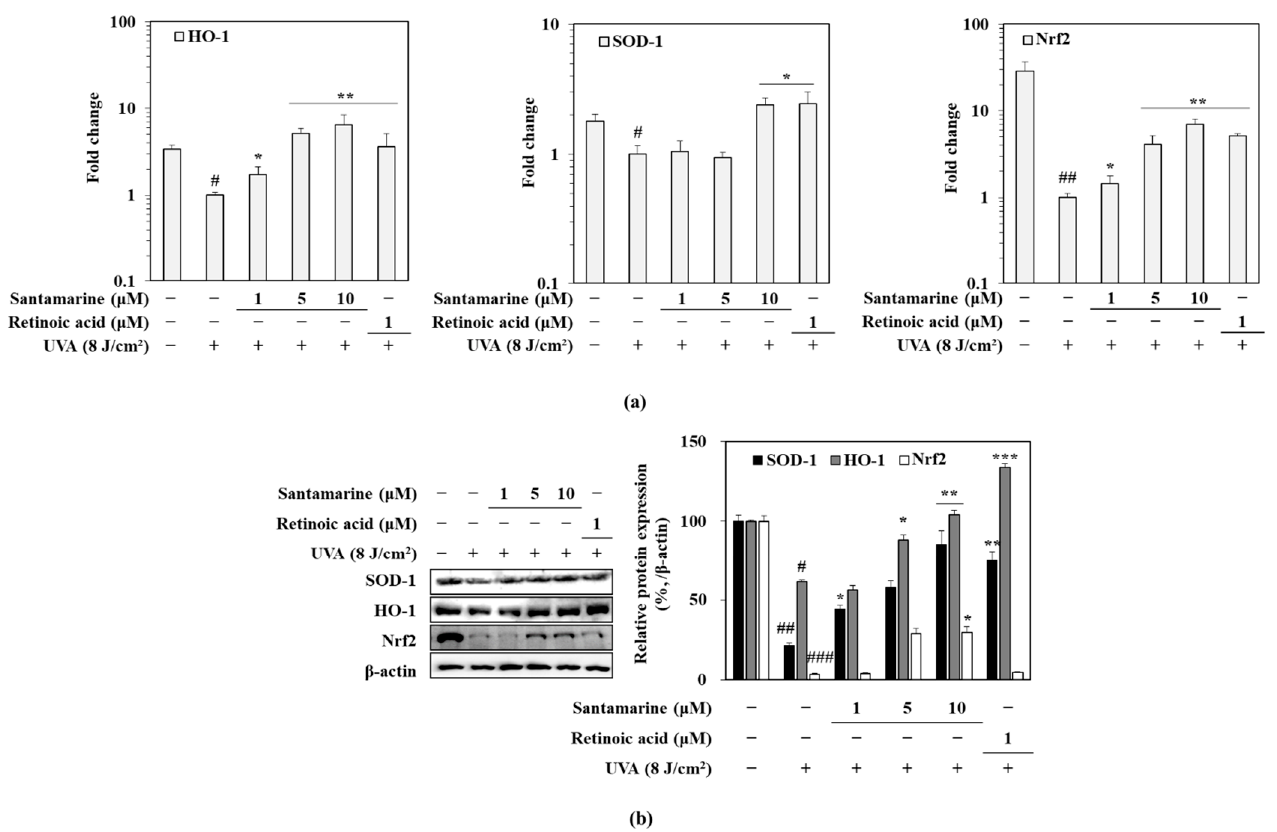
Figure 8. Effect of santamarine on Nrf2-dependent intracellular antioxidant mechanism. The mRNA expression ( a ) and total protein levels ( b ) of Nrf2 and dependent antioxidant enzymes SOD-1 and HO-1 were analyzed using RT-qPCR and Western blot, respectively, after 24 h treatment in UVA-irradiated (8 J/cm 2 ) HDFs. β -actin was used as a loading control. Values are means ± SD ( n = 3). * p < 0.05, ** p < 0.01 and *** p < 0.001 vs. UVA-irradiated untreated control. # p < 0.05, ## p < 0.01 and ### p < 0.001 vs. non-irradiated control. Retinoic acid was used as a positive control.